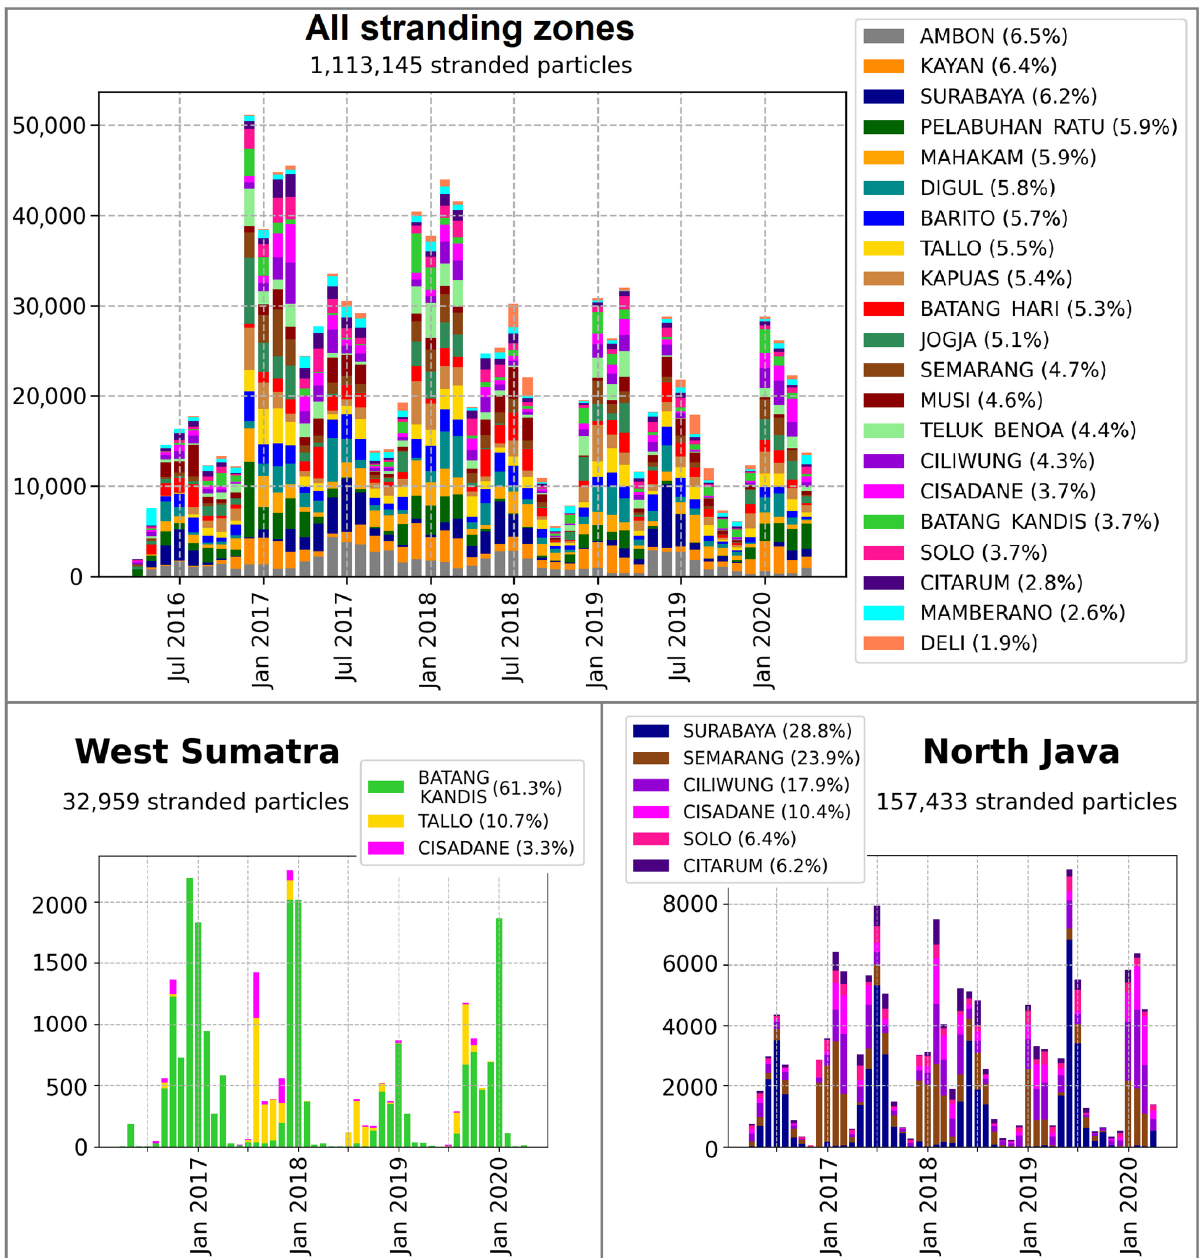
Figure 5. Time series of particle strandings along the coasts of the entire region ( upper panel ), West Sumatra ( lower left panel ) and North Java ( lower right panel ). Note that the ordinate axis range differs between the three